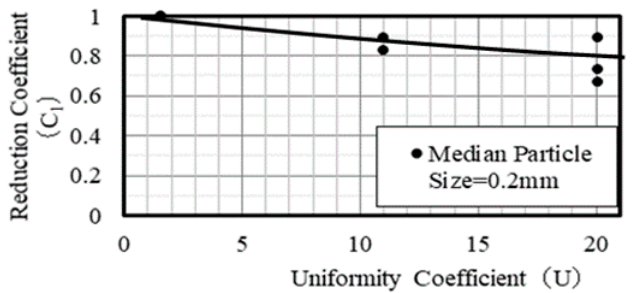
Figure 4. Influence of the uniformity coefficient to the bed-load reduction coefficient (the median grain size is 0.2 mm, dry densities are around 1.5 g/cm 3 ).